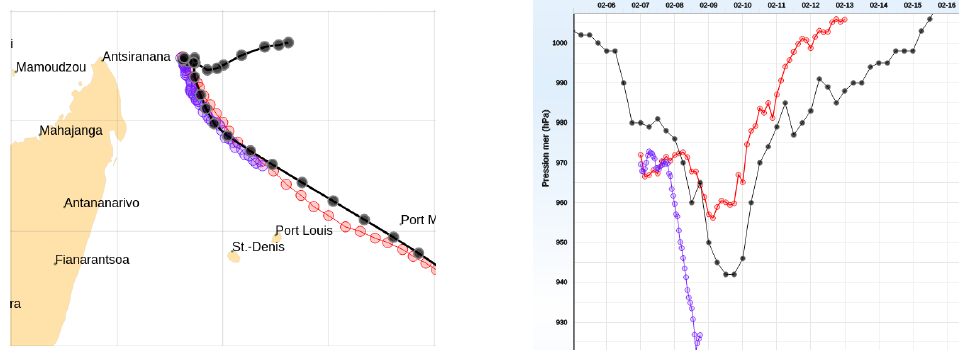
Figure 9. Trajectory ( left ) and evolution of MSLP ( right ) for TC GELENA from 5 to 16 February 2019. BT analyses (black), 42-h lead time forecasts starting from 7 February 00:00Z for operational AROME- OI model (purple) and 144-h lead time forecasts starting from 7 February 00:00Z for operational IFS model